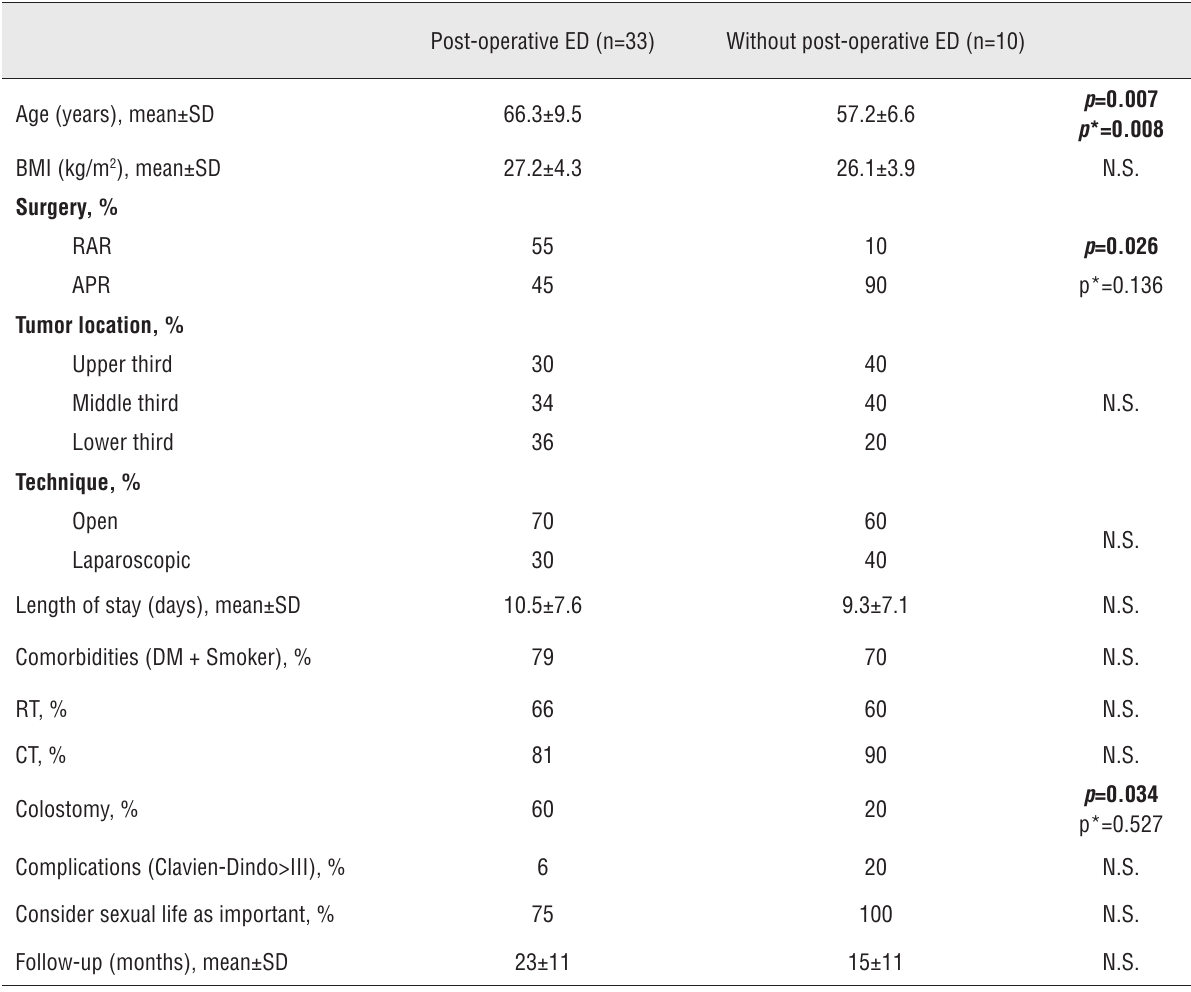
Table 3 – univariate and multivariate* analysis comparing characteristics of patients with and without post-operative erectile